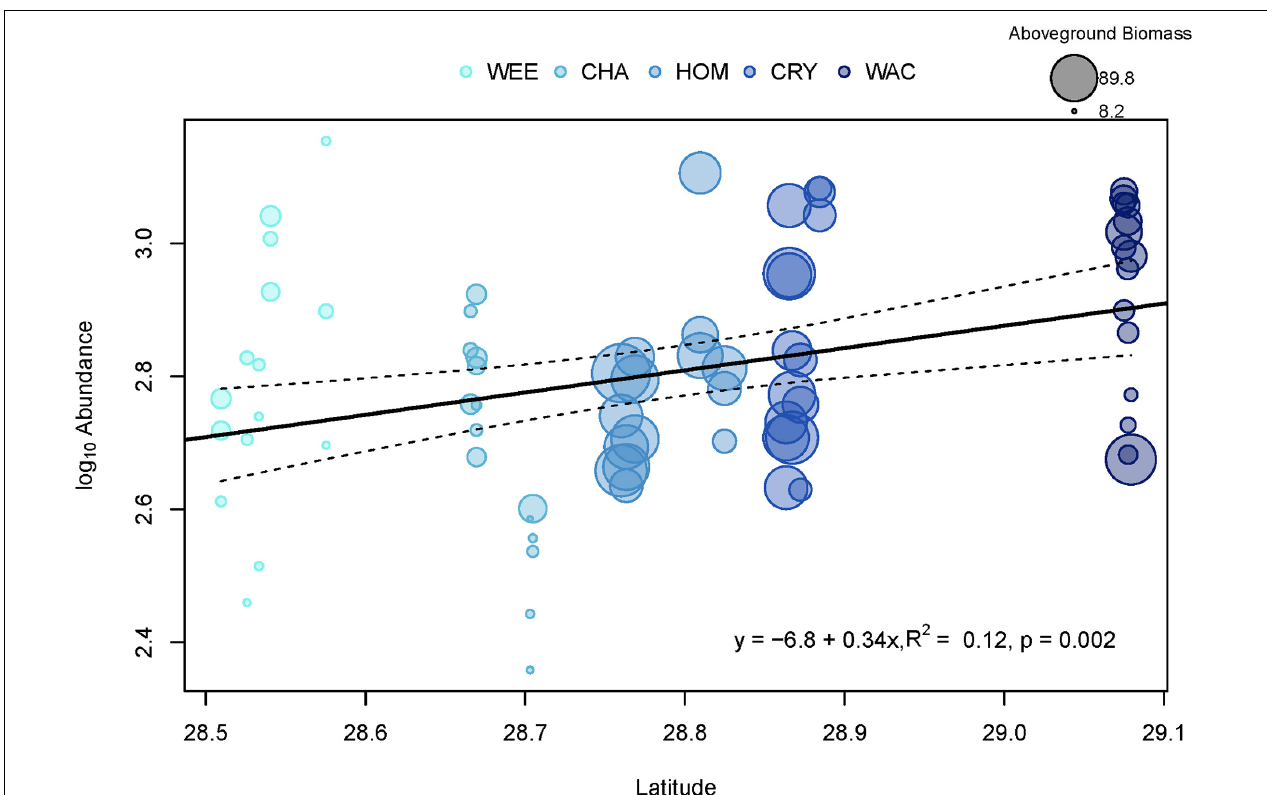
FIGURE 2 | Linear regression of log 10 total faunal abundances for each sample against latitude. WEE, Weeki Wachee; CHA, Chassahowitzka; HOM, Homosassa; CRY, Crystal River; WAC, Waccasassa. Dashed lines represent the 95% confidence interval of the fitted line (solid line). Colors indicate relative levels of long-term total phosphorus (TP) concentrations in the water column, with lighter colors indicating lower TP. Sizes of points represent the total dry weight of vegetative biomass in grams, with larger sizes indicating a higher aboveground vegetative